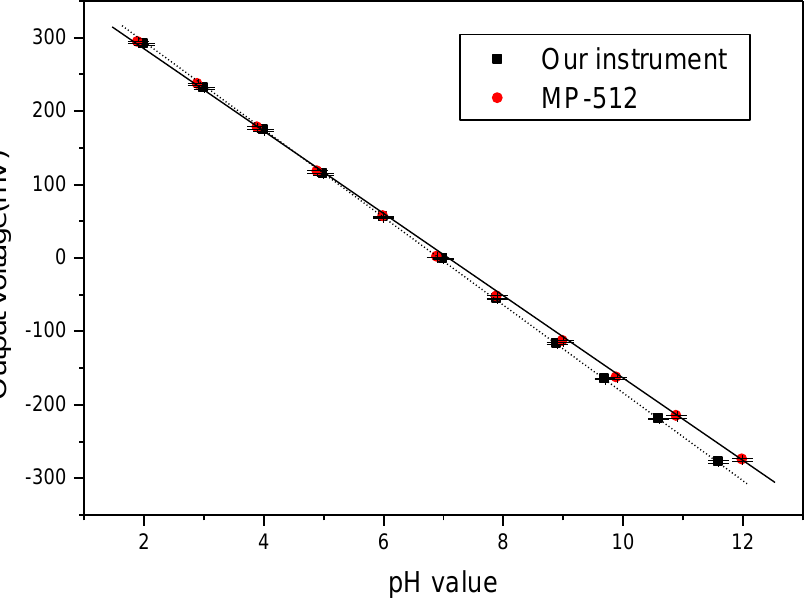
Figure 9. The plot of output voltage for different pH solutions.